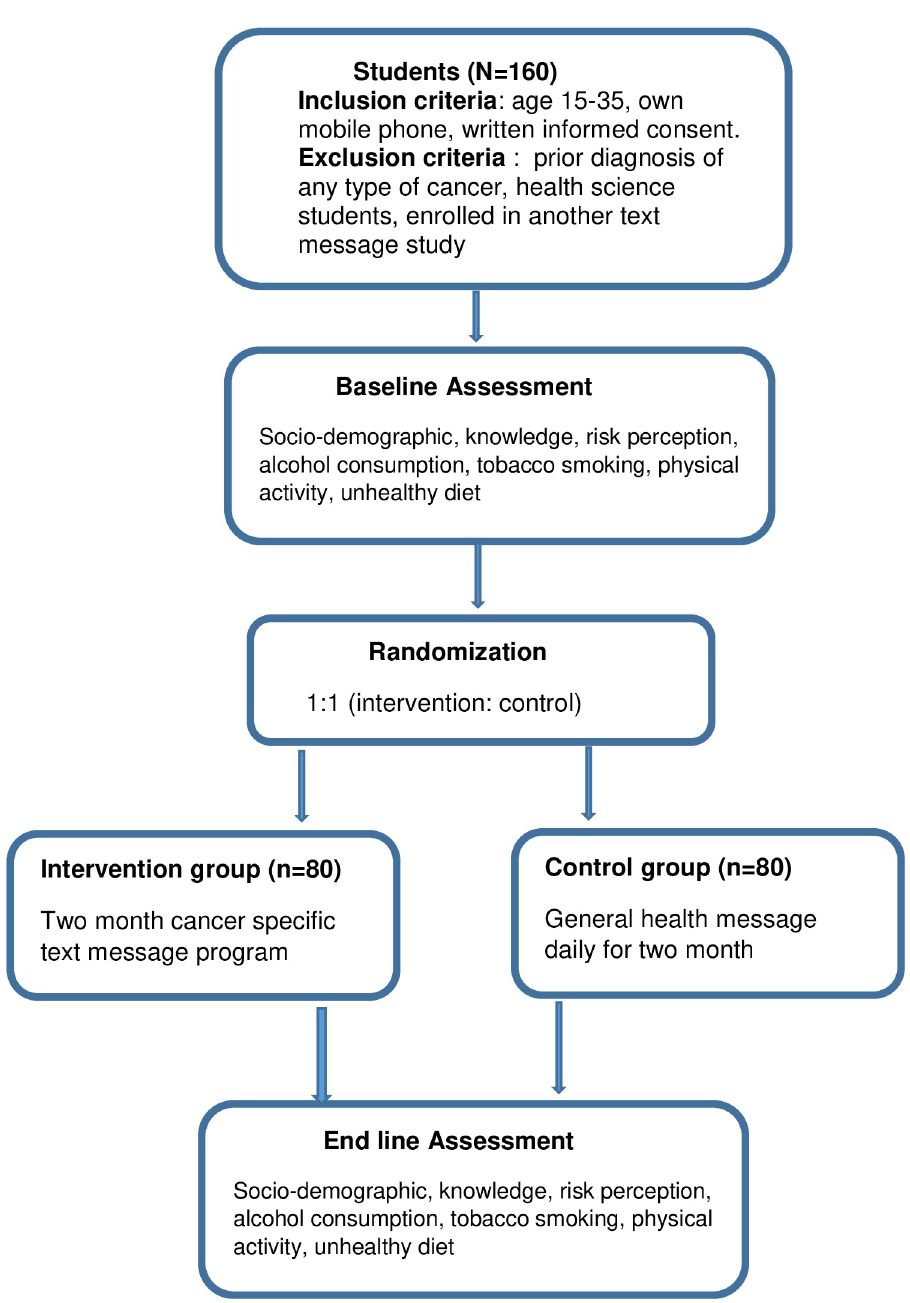
Fig 1. Study flow diagram of text message program on knowledge and perception towards behavioral risk factor of cancer.